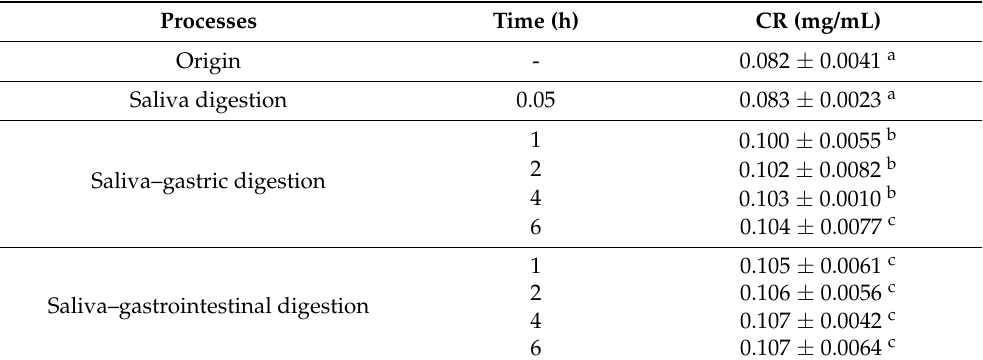
Table 1. Changes in reducing sugar contents in HPS during in vitro